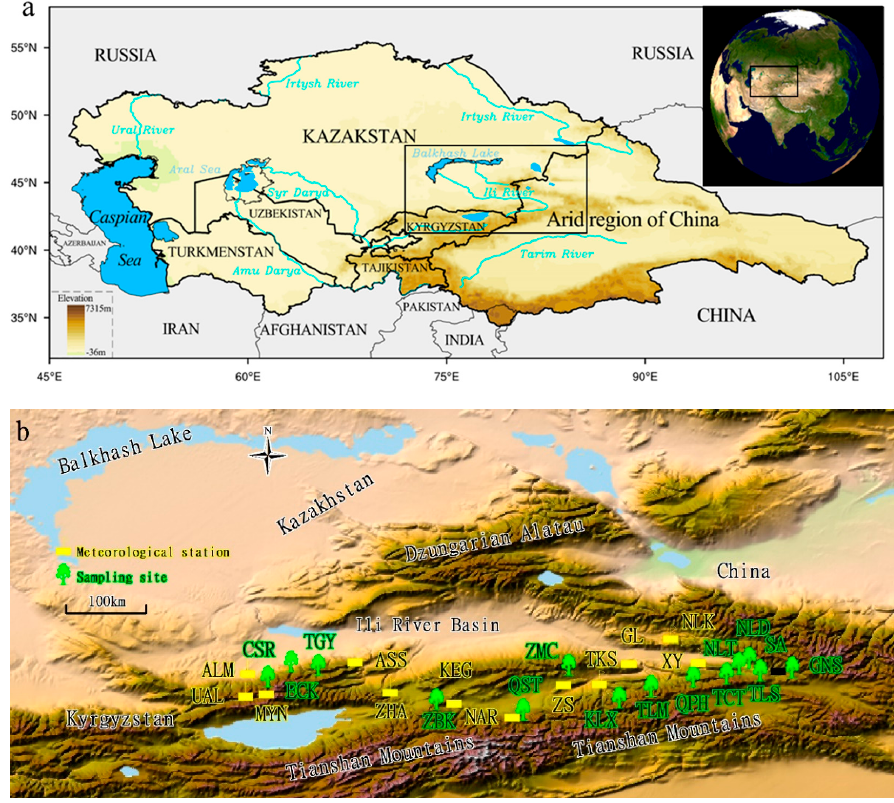
Figure 1. Locations of study area and sampling sites. ( a ) Map of arid Central Asia; ( b ) locations of meteorological stations and sampling sites. Table 1. Basic information for each of the sampling sites.